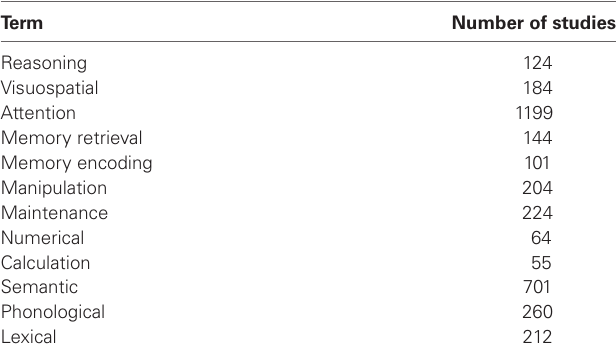
Table 1 | The number of studies included in the Neurosynth meta-analysis, for each term